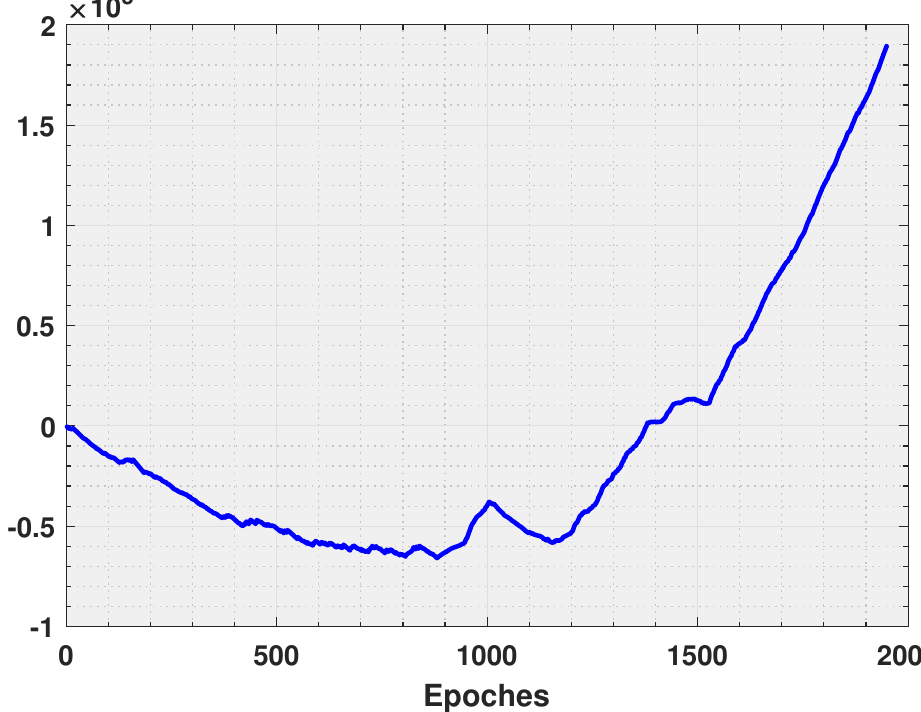
Figure 22. Cumulative total reward for Model 3 intelligent decision making over the course of the